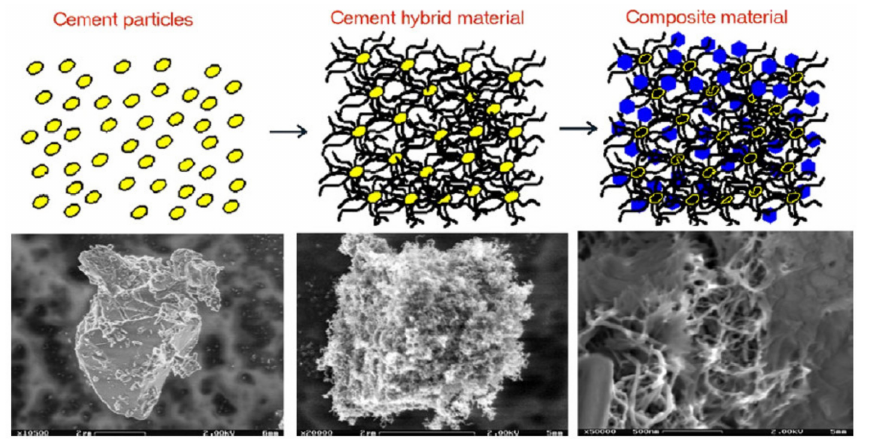
Figure 30. Schematic representation of CNT/CNF growing process. Reproduced with permission from [96], Elsevier,